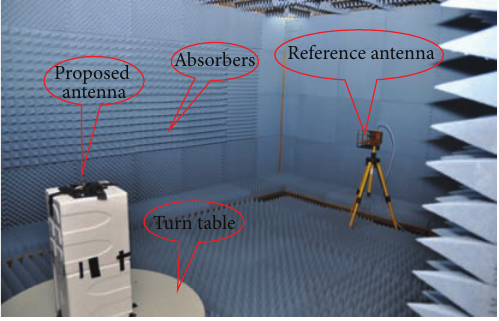
Figure 13: Anechoic